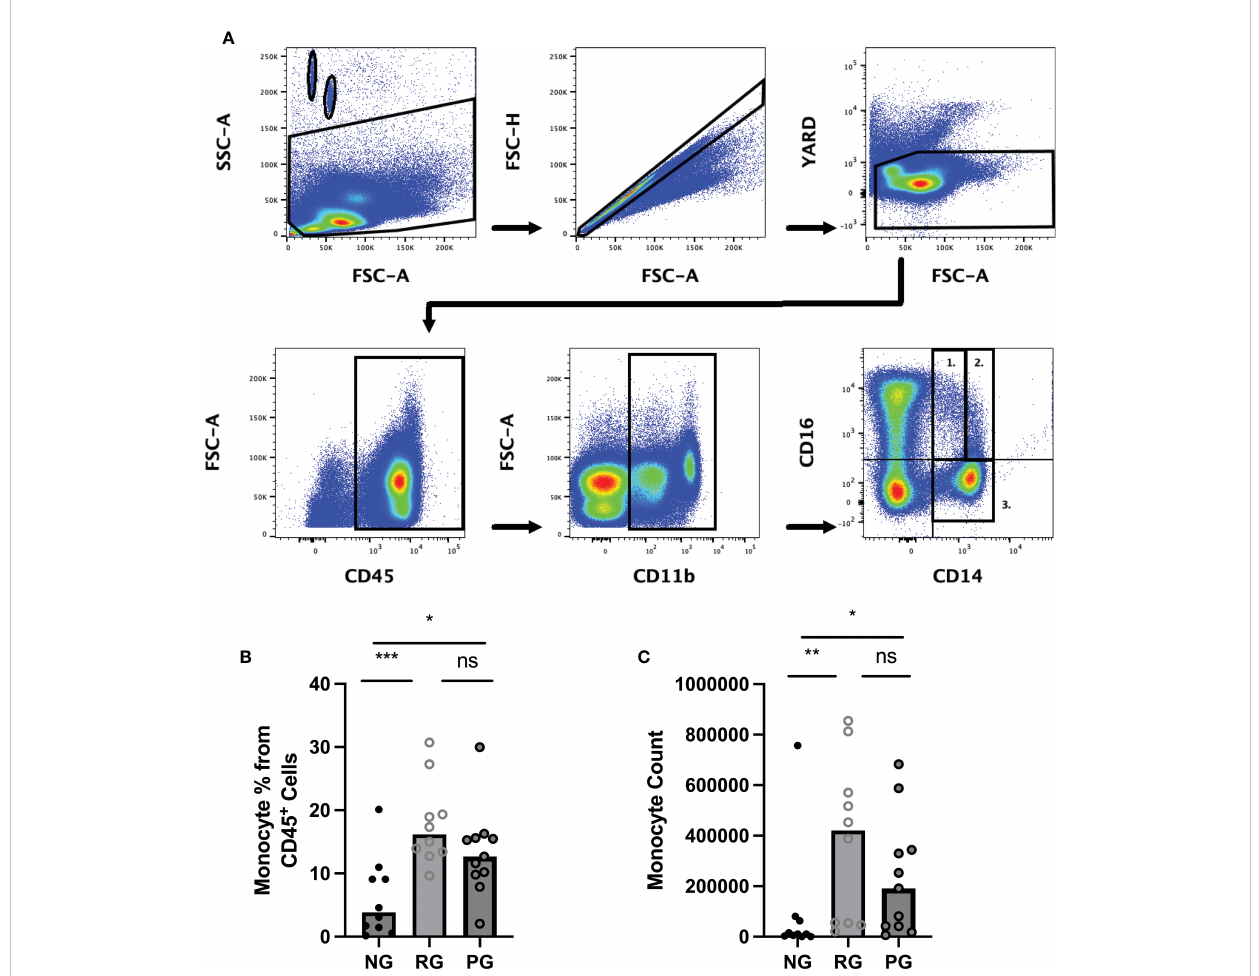
FIGURE 2 Comparison of circulating monocyte levels among the groups. Representative fl ow cytometry gating strategy for identi fi cation of monocytes and monocyte subsets in PBMC from NG, RG, and PG groups. Lymphocytes and monocytes were selected using CD45 + followed by gating for CD11b + cells. (A1) non-classical (CD14 lo /CD16 + ), (A2) intermediate (CD14 + /CD16 + , (A3) Classical (CD14 + /CD16 - ), and (B) Total monocyte percentages as a proportion of total identi fi ed CD45 + cells in NG, RG, and PG groups. (C) Total monocyte counts in NG, RG, and PG groups. Mann-Whitney-U Test *p < 0.05, **p < 0.01, ***p < 0.001, ns, non-signi fi